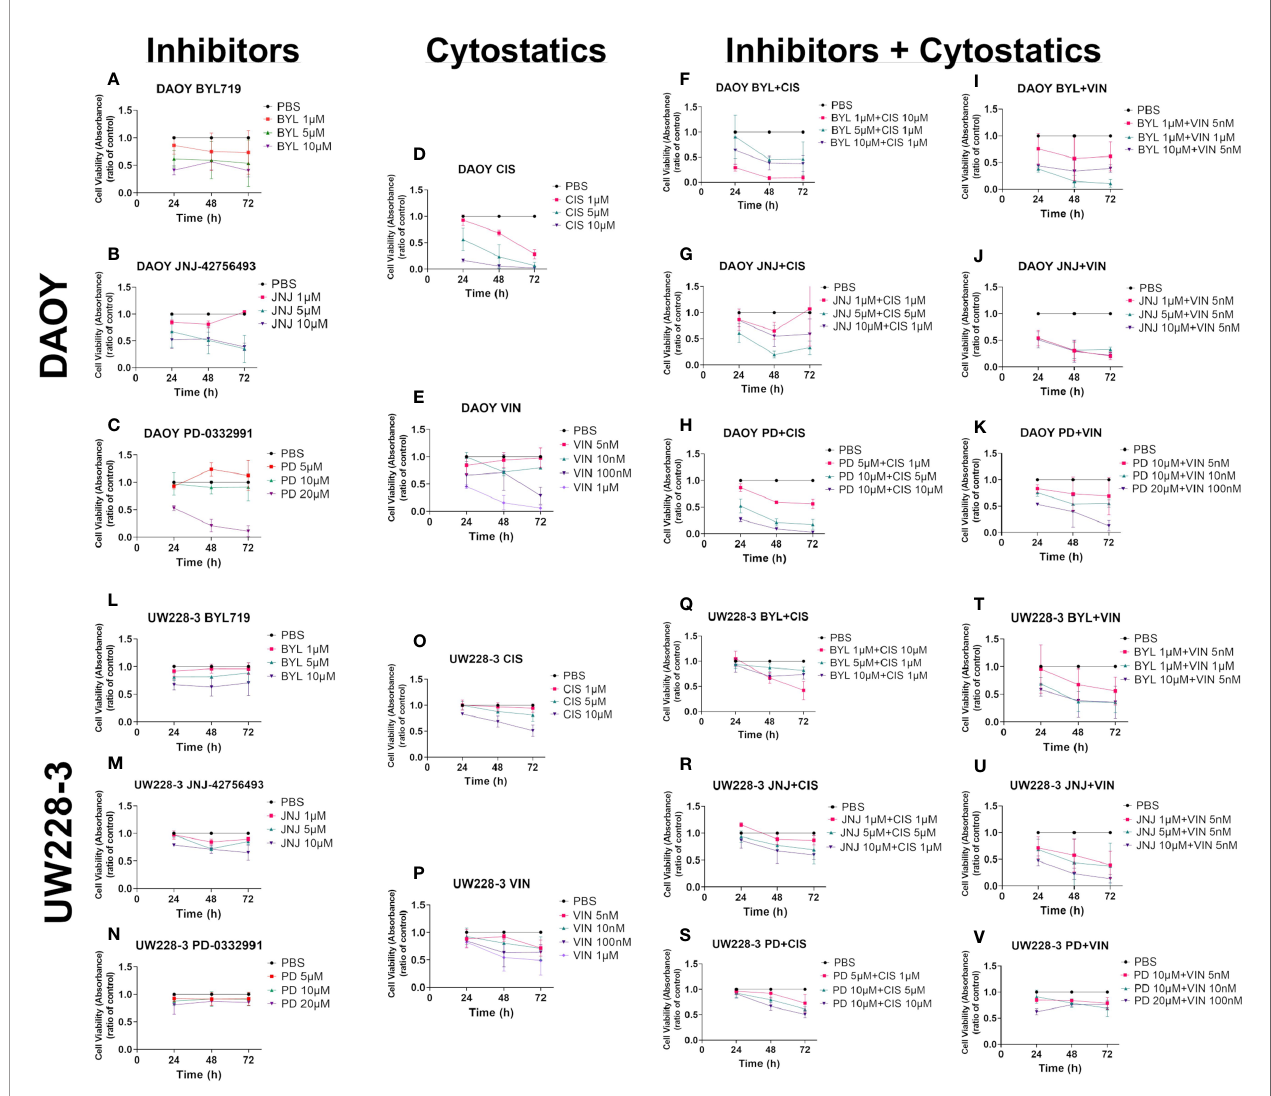
FIGURE 4 | WST-1 viability assays after single and combinational treatment of BYL719, JNJ-42756493, and PD-0332991, respectively, with cisplatin or vincristine respectively on DAOY or UW228-3. Viability analysis measured as absorbance, after treatment of DAOY and UW228-3 respectively, for 24, 48, and 72 h with BYL719 (A, L) , JNJ-42756493 (B, M) ; and PD-0332991 (C, N) , Cisplatin (D, O) , and Vincristine (E, P) , respectively. Combinational treatments are shown for DAOY (F – K) and UW228-3 (Q – V) . The graphs represent mean values ± standard deviation (SD) from three experimental runs per cell line. BYL, BYL719; JNJ,